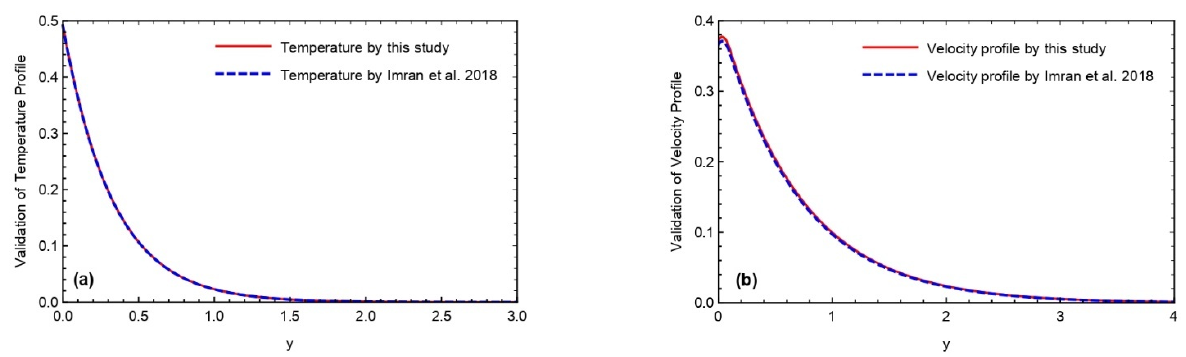
Figure 15. Validation attained results with the results of Imran et al. [54]. ( a ) Temperature. ( b ) Ve- locity.